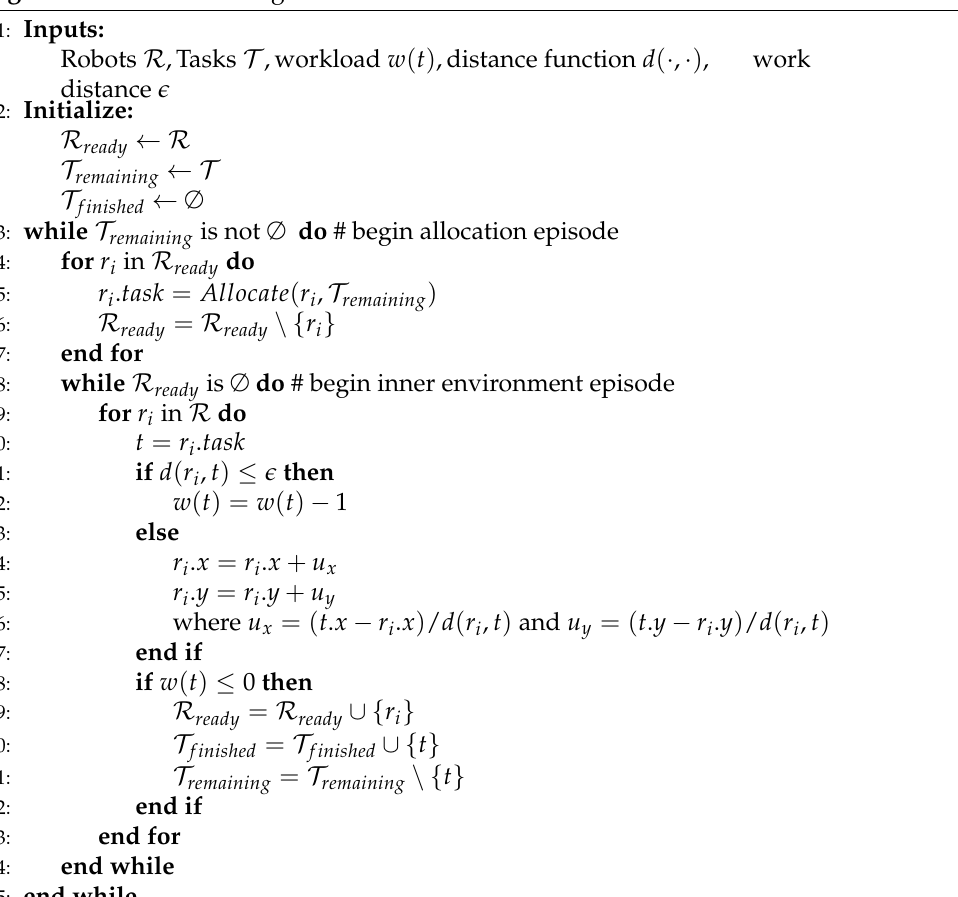
Algorithm 1 Allocation Algorithm in